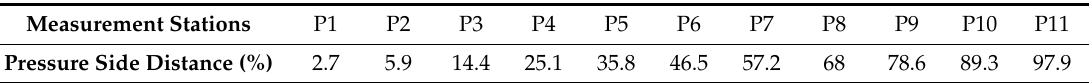
Table 3. Measurement stations of the DCA pressure side as a percentage of the pressure side length (illustrated in Figure 4).